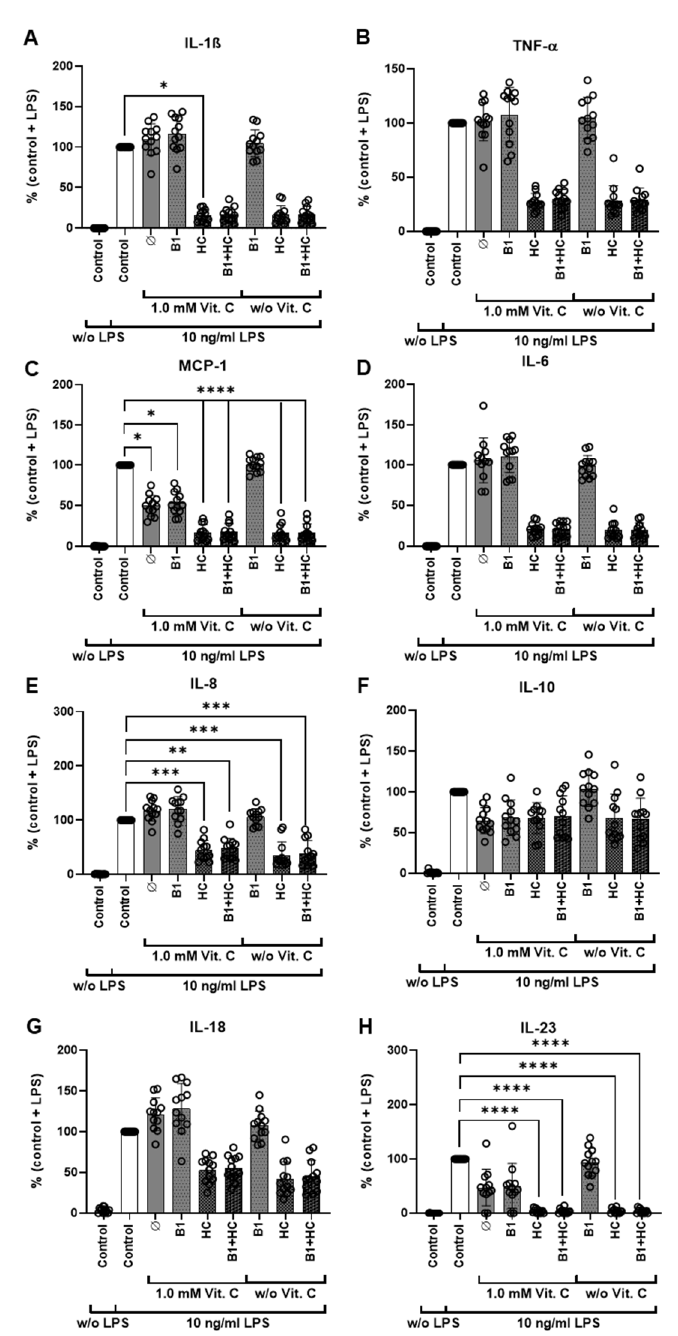
Figure 4. Detailed cytokine secretion analysis after vitamin C, vitamin B1, and hydrocortisone treatment. ( A – H ). The amount of the cytokines was determined using LEGENDplex TM followed by flow cytometry after treatment of the cells for 6 h with either vitamin C, vitamin B1, or hydrocortisone alone or in combination and with or without LPS. LPS (10 ng/mL); Vit. C = Vitamin C (1 mM); B1 (1 µ M); HC (2 µ M); *: p ≤ 0.05; **: p ≤ 0.01; ***: p ≤ 0.001; ****: p ≤ 0.0001. Additional data analysis stratified according to gender is available as Figure S5. B1 = vitamin B1; HC = hydrocortisone; IL = interleukin; LPS = bacterial lipopolysaccharides; MCP = monocyte chemo-attractant protein; TNF = tumor necrosis factor; Vit. C = vitamin